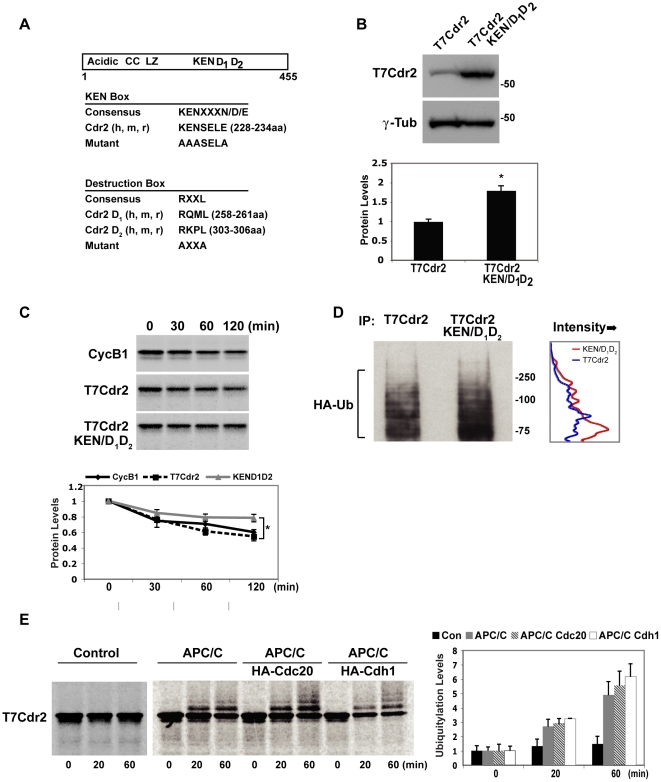
KEN and D box mutants stabilize Cdr2.A. Cdr2 schematic depicting acidic, coiled coil (CC) and leucine zipper (LZ) motifs and KEN and D (D1, D2) boxes. Lower panels, alignment of consensus KEN and D box motifs with human (h), mouse (m) and rat (r) cdr2 and mutants. Amino acid residue numbers are from human Cdr2. B. Upper, HEK293s transfected with T7cdr2 or T7cdr2 KEN/D1D2, released from G2/M block and blotted with T7 or γ-tubulin antisera. Lower, quantitation of T7cdr2 and T7cdr2 KEN/D1D2 levels normalized to γ-tubulin. *p<0.01. C. Upper, autoradiographs of degradation assays of 35S-labeled cyclinB1, T7cdr2 and T7cdr2 KEN/D1D2 at indicated times. Lower, quantitation of raw cyclinB1, T7cdr2 and T7cdr2 KEN/D1D2 levels. *p<0.05. D. Left, anti-HA blot of T7 immunoprecipitates from HEK293s transfected with T7cdr2 or T7cdr2 KEN/D1D2 and HA-Ub (see Fig. S2); right, line graph of band intensity (x-axis) for adjacent western blot and molecular weight (y-axis); T7cdr2 (blue), KEN/D1D2 (red). E. Left, autoradiographs of 35S-T7cdr2 ubiquitination reaction with the APC/C, APC/C/HACdc20, APC/C/HACdh1, or control (Protein A beads) for indicated times. Right, quantitation of T7cdr2-Ub conjugates.